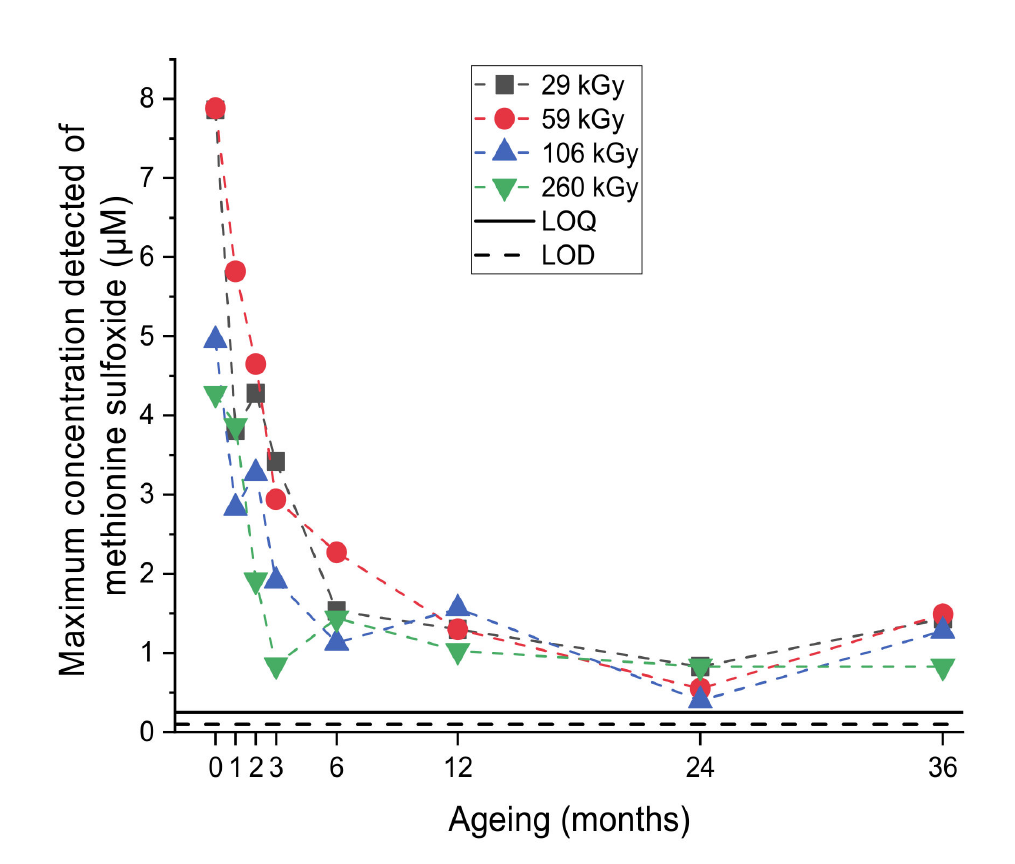
Figure 6. Plots of aging before filling versus maximum methionine sulfoxide concentration detected at di ff erent doses.